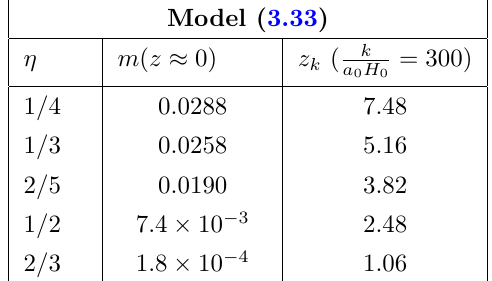
where we used the approximation for m valid during matter dominated epoch ( µ 2 (cid:28) R ) µ 2 = Ω H 2 (see (2.20)) and the conditions (3.17) and (3.22) valid for both models. m 0 0